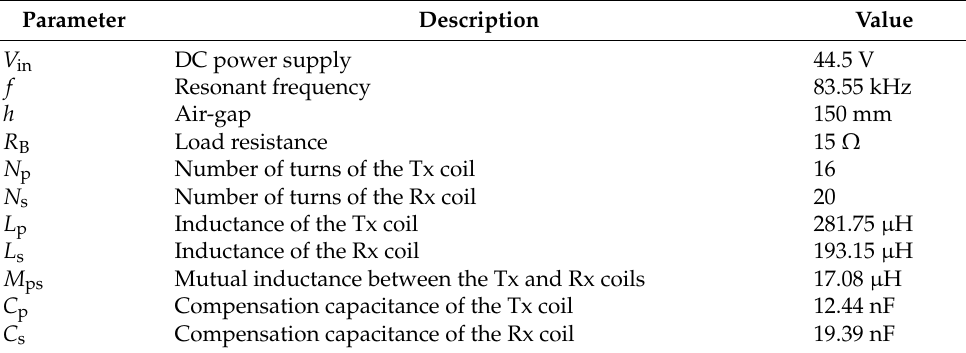
Table 3. Parameters of the two-coil WPT